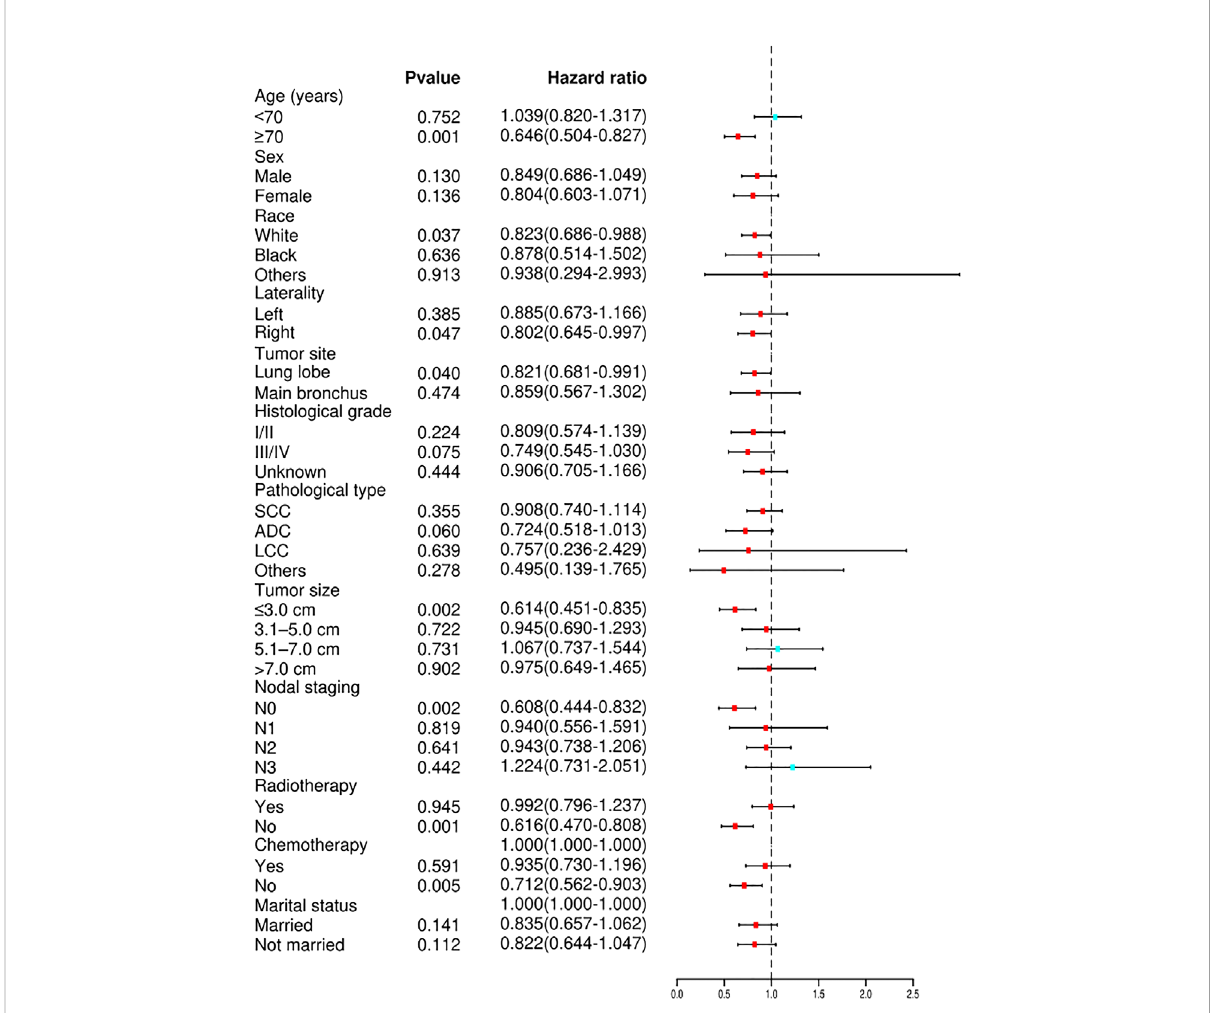
FIGURE 5 Forest plot depicting subgroup analysis of the CSS between the TA and non-ablation groups after PSM. SCC, squamous cell carcinoma; ADC, adenocarcinoma; LCC, large cell carcinoma; CSS, cancer-speci fi c survival; TA, thermal ablation; PSM, propensity score